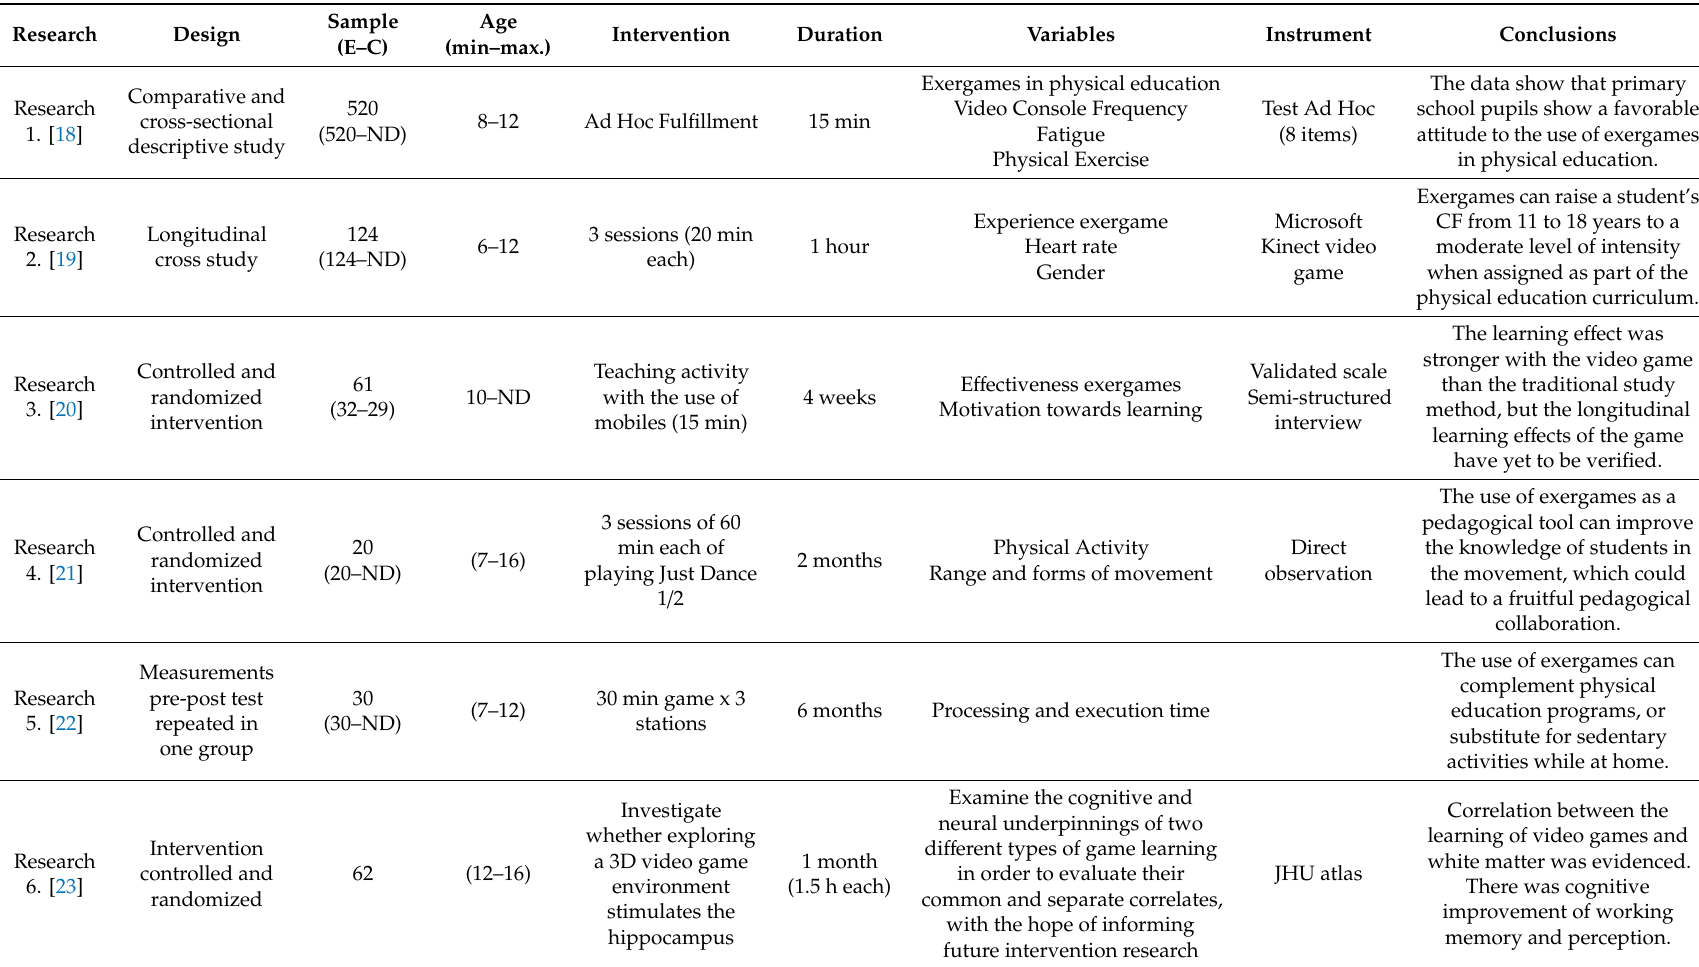
Table 1. Papers that address exergames and physical activity in